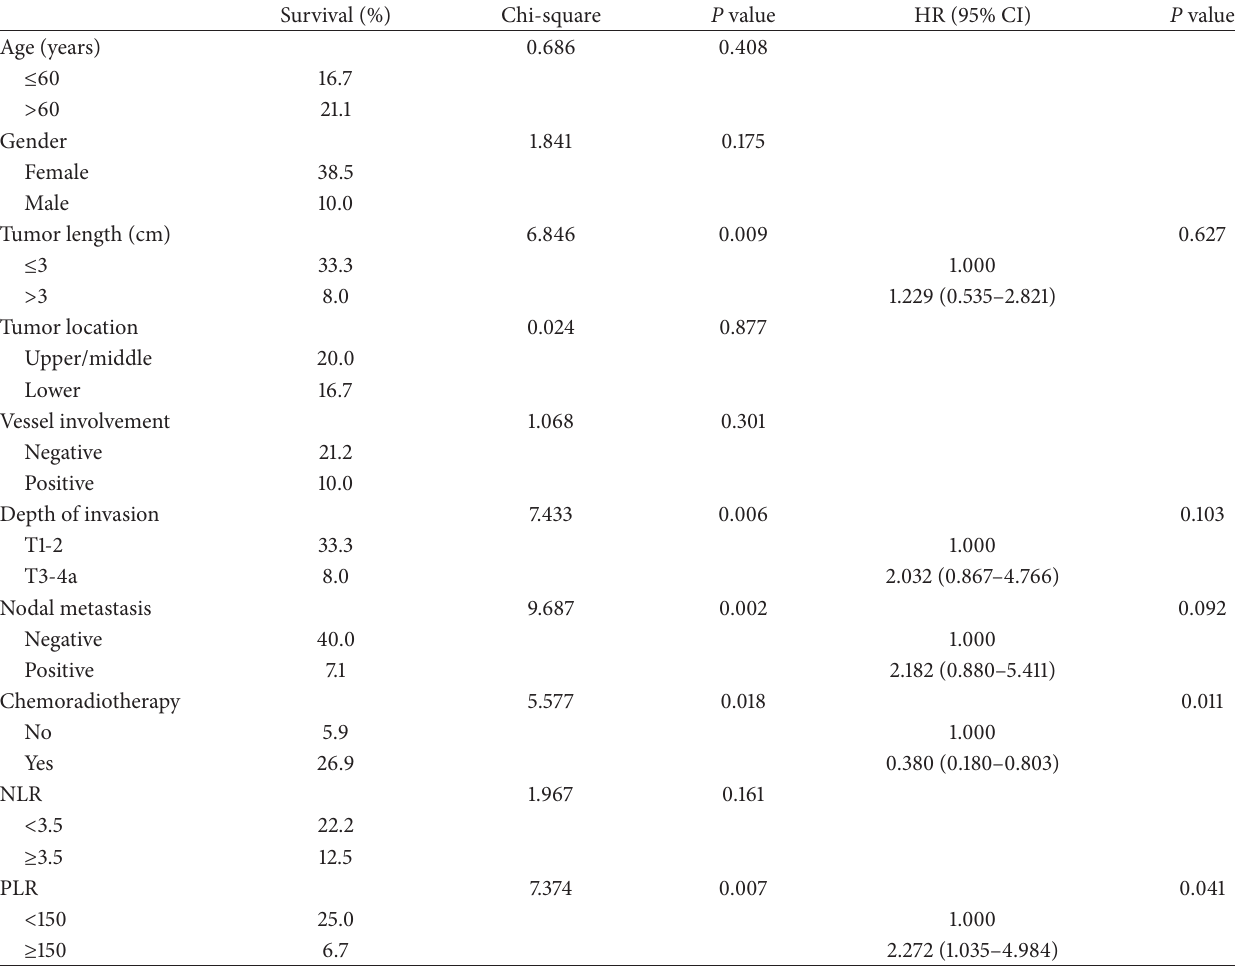
Table 3: Univariate and multivariate analyses of OS in SCCE